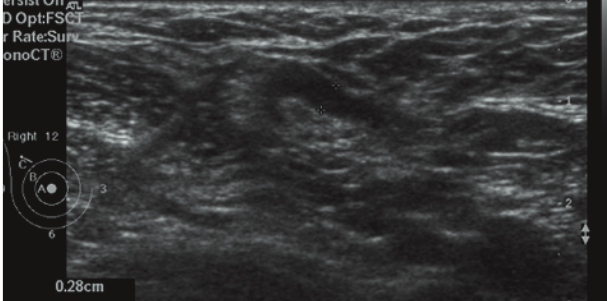
Fig. 2. Ultrasound of the right axilla shows an enlarged lymph node with cortical thickness of 6.6 mm.